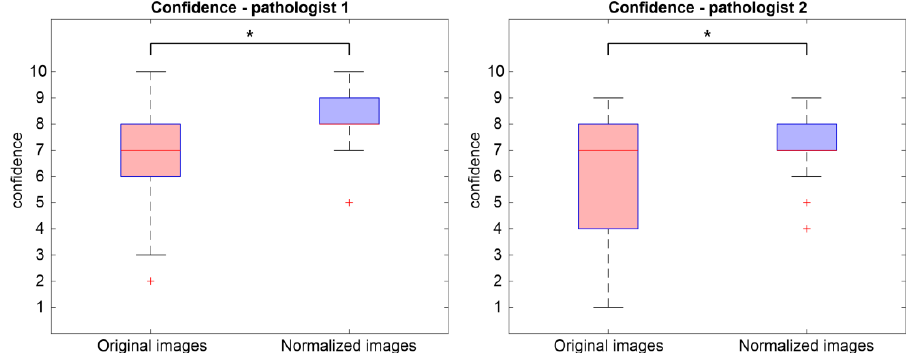
Figure 8. Boxplots of confidence values. Overall distribution of confidence values of original (red) and normalized images (blue) according to the evaluations of the first pathologist (P1) on the left and second one (P2) on the right. The plus symbol (+) indicates outliers in the distribution, while the asterisk (*) denotes a statistically significant difference between original and normalized images.